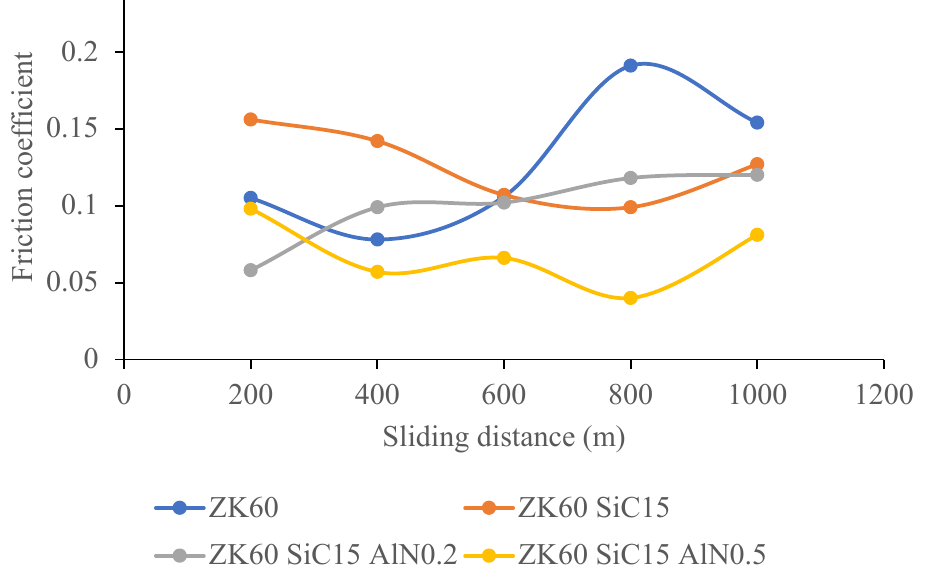
Figure 14. The comparison of the change of the friction coefficient depending on the sliding distance for all samples.